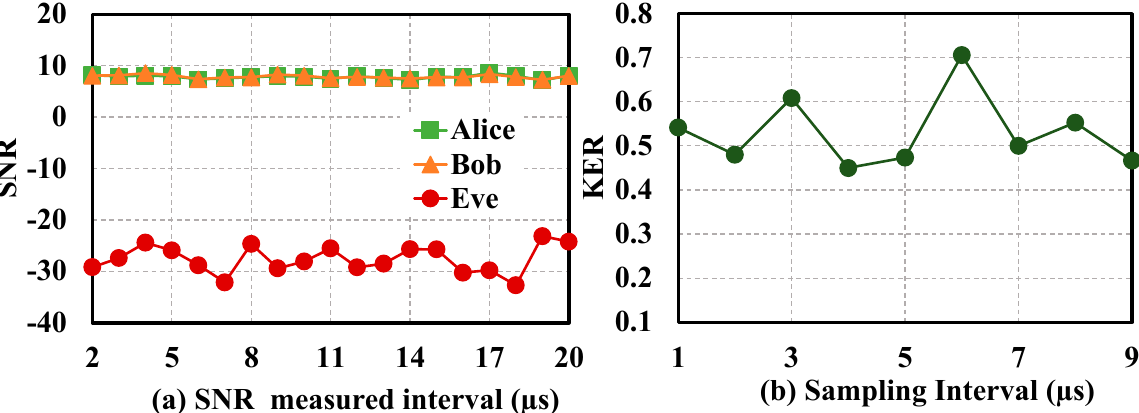
Figure 8. ( a ) The measured value curve of Alice and Bob Eve SNR, and ( b ) the change curve of the error rate of Eve key .